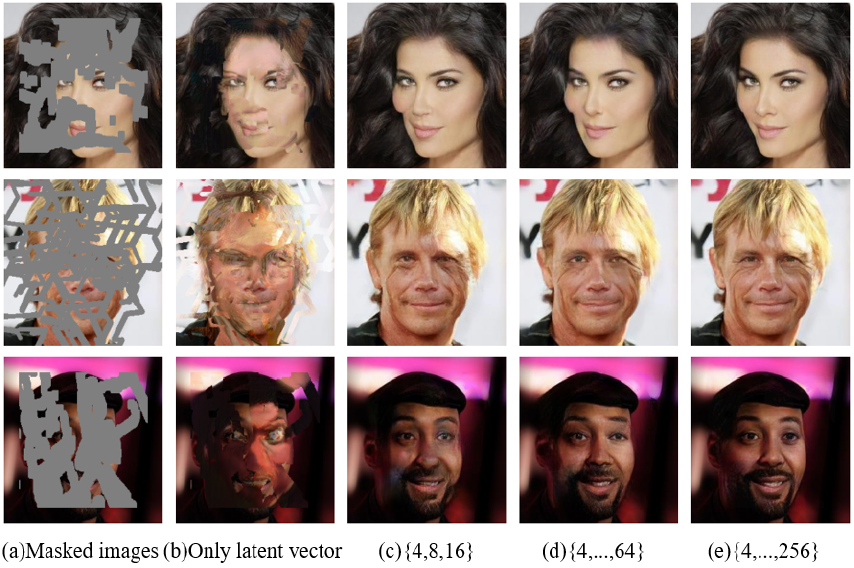
Figure 6. The effect of multi-resolution encoder on completion results.